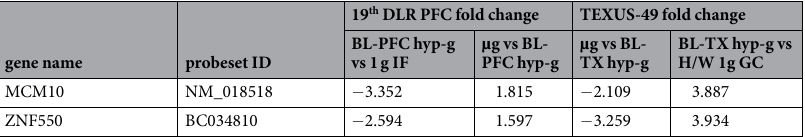
Table 8. Differentially regulated annotated transcripts identified for the parabolic flight and sounding rocket campaign data sets. Comparison of the intersections of hyper- and microgravity-double-sensitive transcripts revealed 57 annotated transcripts differentially regulated in all conditions for the 19 th DLR parabolic flight and TEXUS-49 suborbital ballistic rocket campaigns. All transcripts were reversely regulated with respect to micro- and hypergravity conditions within the same platform. Positive sign: significantly up-regulated transcripts (p-value < 0.05, FC ≥ + 1.3), negative sign: significantly down-regulated transcripts (p-value < 0.05, FC ≤ − 1.3). FCs are ratios between the averages of linear expression values. If the ratio is < 1, FC is calculated as the negative reciprocal of the